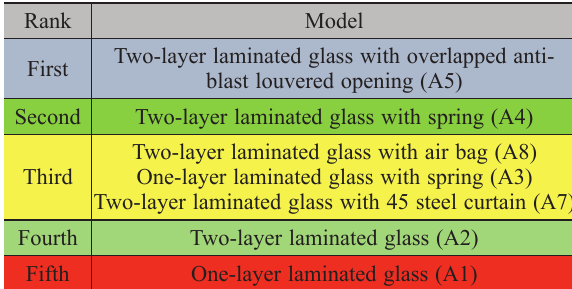
Table 12. Ranking of laminated glass models based on safety provided by them